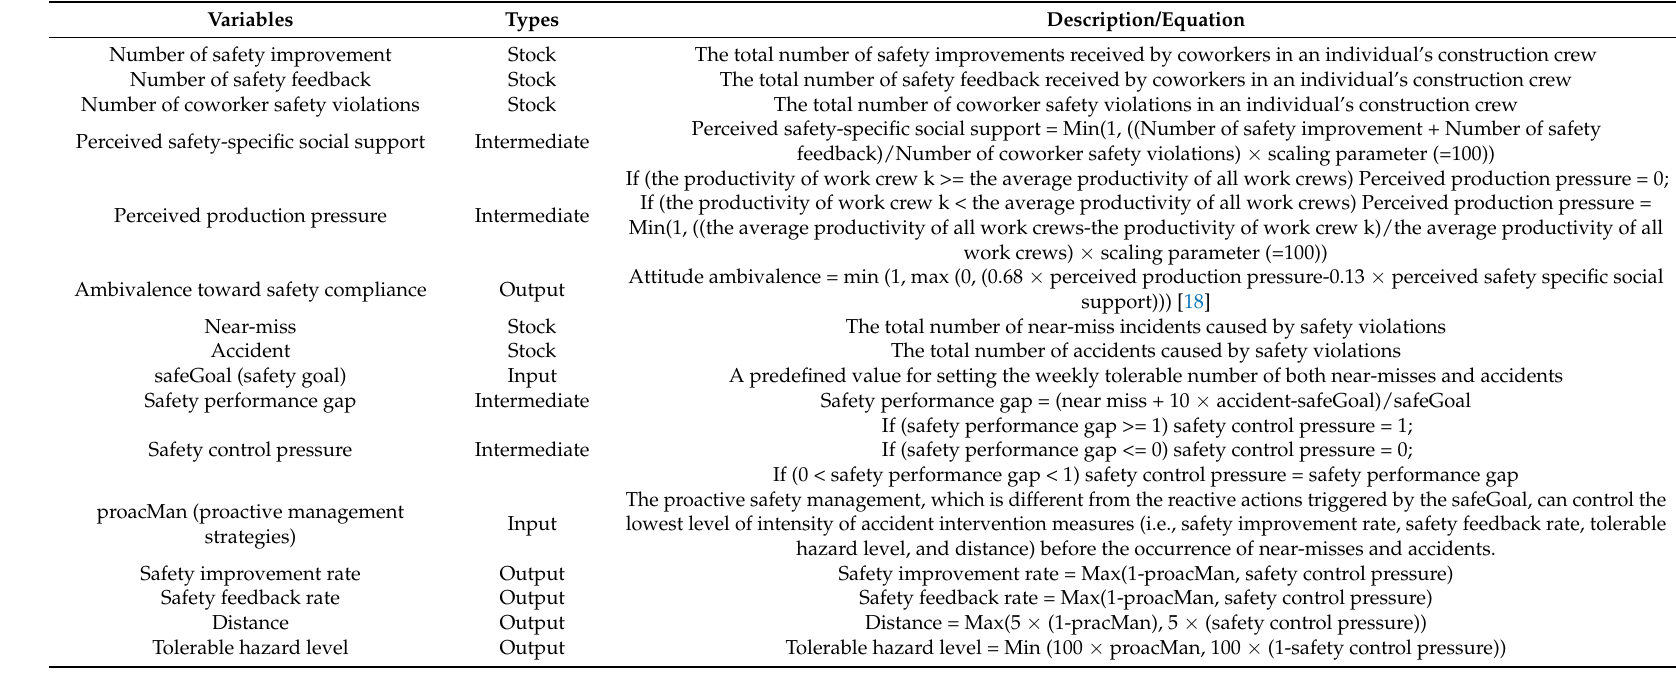
Table 1. Descriptions and equations for variables involved in the SD